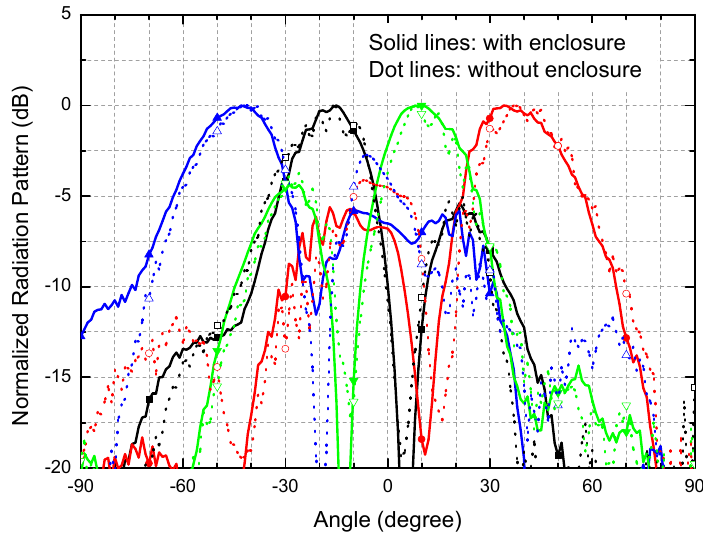
Figure 10. Measured radiation patterns with and without the metal enclosure in 28 GHz. Figure 11 shows the measured radiation patterns at three different frequencies of 27, 28 and 29 GHz. The four beam direction angles are found to be − 45 ◦ / − 43 ◦ / − 41 ◦ , − 15 ◦ / − 17 ◦ / − 17 ◦ , +13 ◦ /+10 ◦ /+8 ◦ , +34 ◦ /+34 ◦ /+38 ◦ at 27/28/29 GHz, respectively. In- deed, the beam direction angles changes slightly, but not significantly, with respect to the operating frequency. The peak gains of four beams are found to be constant at 28 and 29 GHz, showing less than 1 dB variation. However, at 27 GHz, the 2L/2R side-beams show a peak gain drop as high as 2.1–3.0 dB compared to the 1L/1R center-beams. The sidelobe levels are observed to be <3.1 dB at 27 GHz and <5.0 dB at 29 GHz, while it is <5.3 dB at 28 GHz. Overall, the antenna shows reasonably wideband performance over the frequency band of 27–29 GHz. When the operating frequency goes further out of the 27–29 GHz band, rapid performance degradations are also observed.